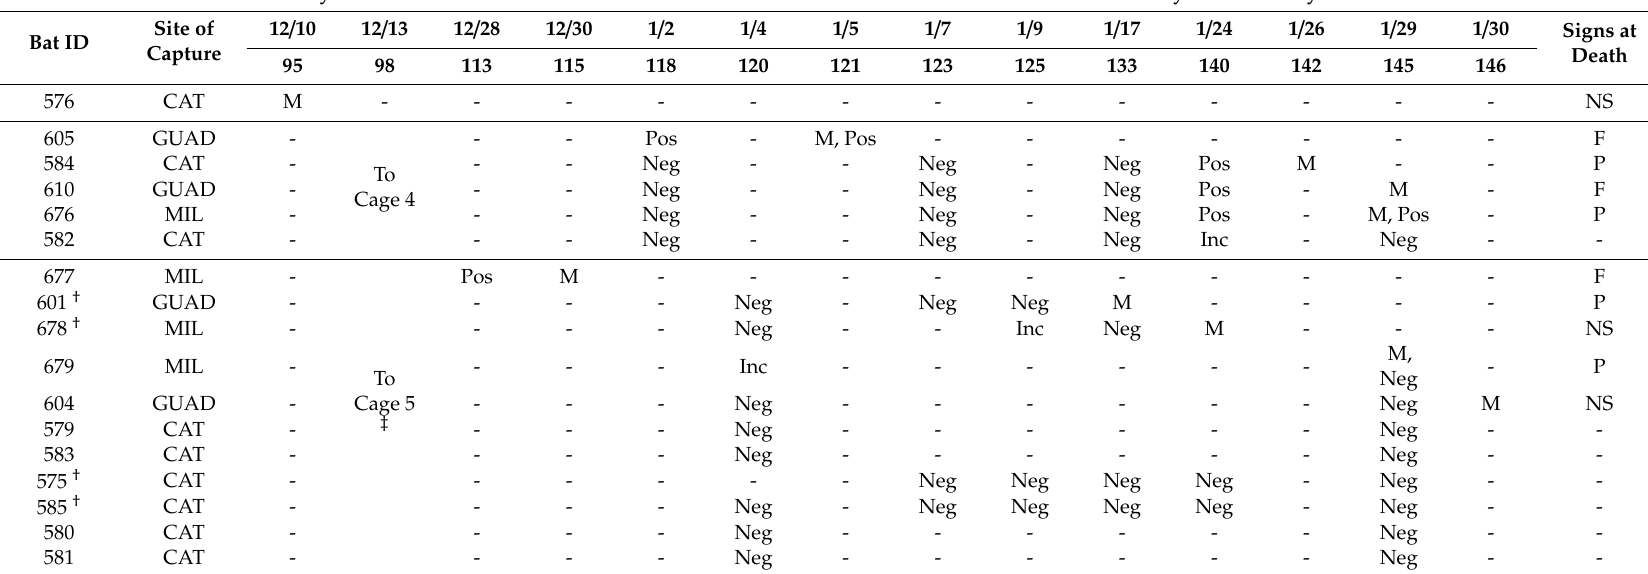
Table 1. Rabies mortality during outbreak in captive vampire bats by capture site in M é xico (Guadalc á zar—GUAD; Catedral—CAT; Milagro—MIL). Bats were placed together in a single cage on Day 0 and then split into 2 cages on Day 98 (calendar date indicated above). Oral swabs collected periodically were tested for rabies virus by real-time RT-PCR (Pos = PCR positive, Neg = PCR negative; Inc = inconclusive). Bats that died and were confirmed rabies positive by DFA are indicated (M) on day of death. Clinical signs present at time of death (F = furious, P = paralytic, NS = no clinical signs, - = did not